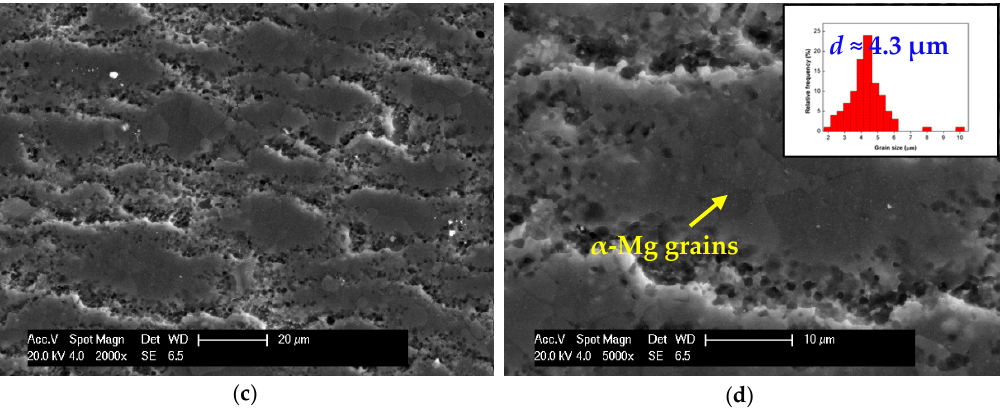
Figure 6. SEM images of peak aged Mg-10Y-6Gd-1.5Zn-0.5Zr alloys at T5 ( a,b ) and T6 ( c,d ) processing states at low ( a,c ) and high ( b,d ) magnifications (samples were etched with 4 mL nitric acid and 96 mL ethanol).